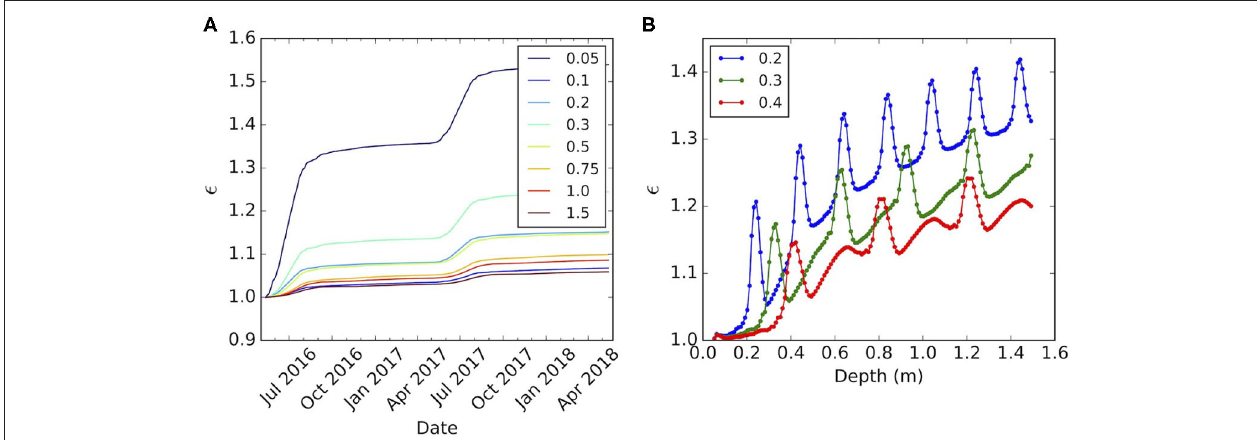
FIGURE 8 | (A) : Modeled evolution of the structural anisotropy ǫ over 2 years with temperature and temperature gradient time series taken from the EastGRIP field measurements at fixed depth in m (legend). (B) : Modeled anisotropy profile using spatio-temporal interpolation of the measured temperatures and gradients for different (constant) accumulation rates in m/year (legend). The start of the time series in (A) and the surface (B) corresponds to May 12. For details see text.